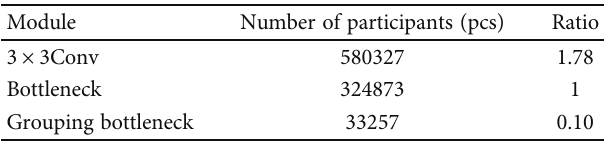
Figure 7: SCAM. Table 3: Comparison of the number of participants before and after bottleneck